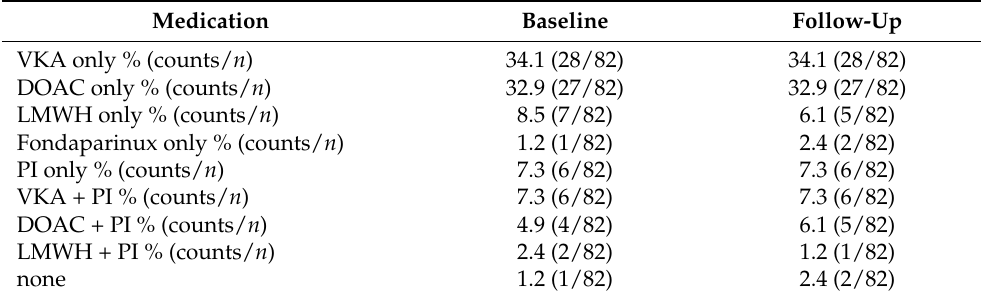
Table 2. Anticoagulant and/or antiplatelet medication in the total study population (n = 82) before (baseline) and after COVID-19 vaccination and/or infection (follow-up). Medication Baseline Follow-Up VKA only % (counts/ n )